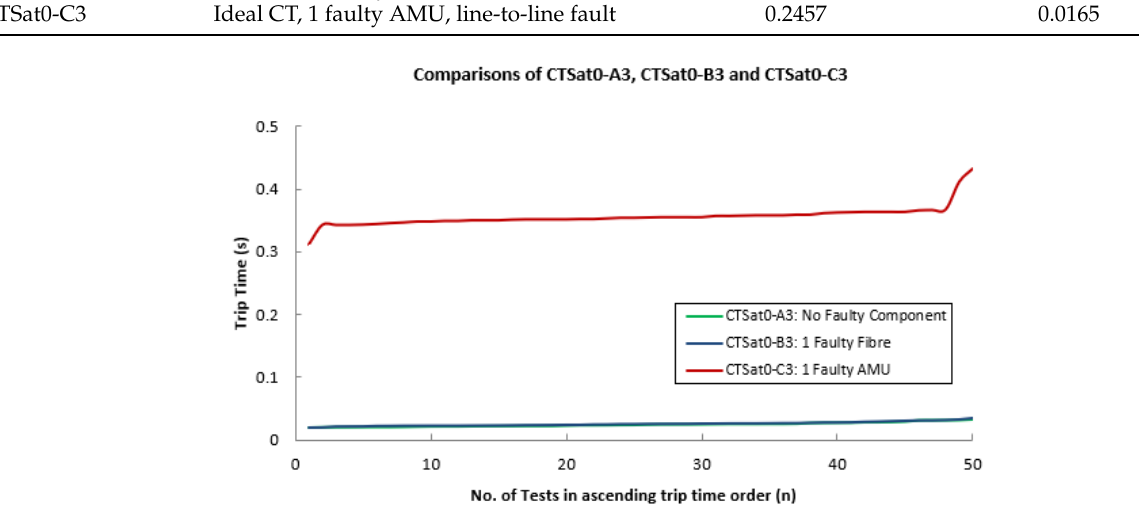
Figure 17. Comparisons for CTSat0-A3, CTSat0-B3 and CTSat0-C3 (ideal CT, no/one faulty compo- nent, L-L-G fault at 100% of the feeder).